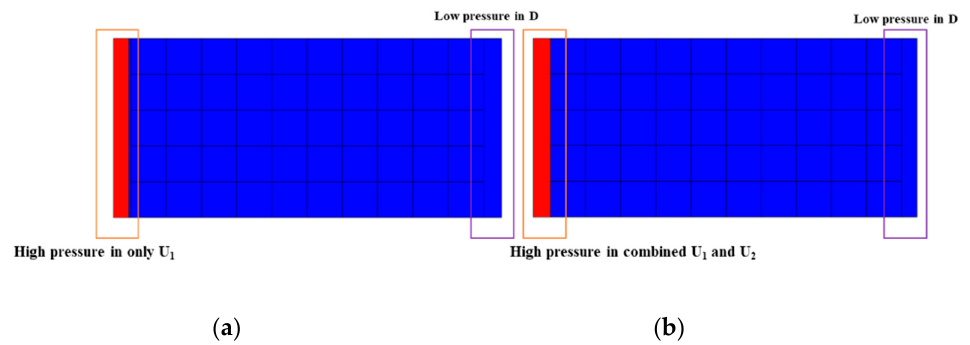
( e ) Pore pressure ≈ 300 psi Up Downn 327.1 psi